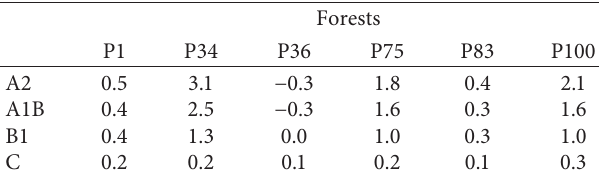
Table 1: Value of pMAI ( m 3 /ha/year ) for small and medium